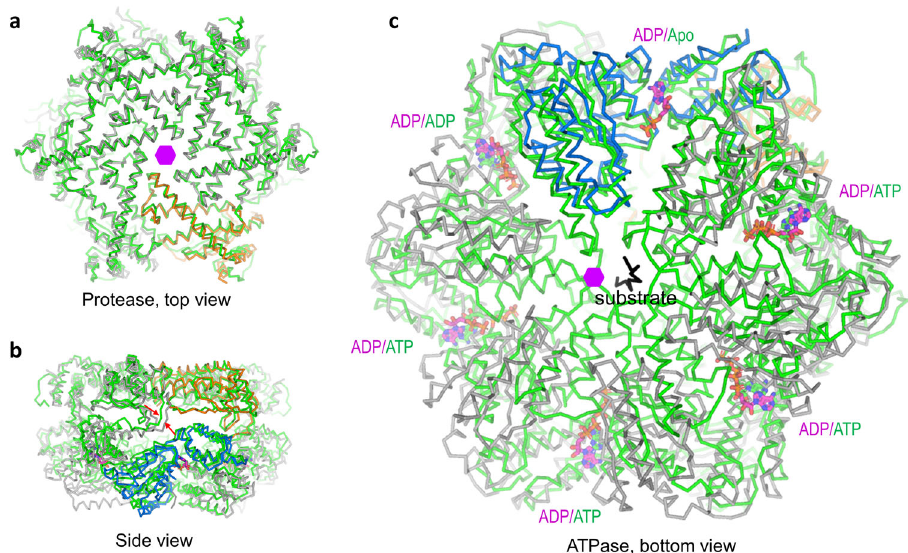
Fig. 4 Structural comparison of ADP-state structure with a substrate loaded yeast homolog structure YME1. a Top view to show the alignment for the protease domain. YME1 structure (PDB code 6AZ0) is colored in green; ADP-state Tm FtsH structure is colored in orange and gray. b Side view to show both protease and ATPase domains. Red arrows indicate the loops connecting the protease and ATPase domains. c Bottom view to show the alignment for the ATPase domains. ADP and ATP molecules are shown as sticks (magenta for Tm FtsH and green for YME1). Substrate is colored in black. Colors of the rest structures are the same as those of Fig. 3c – e. A magenta hexagon indicates the center of the symmetric ADP-state